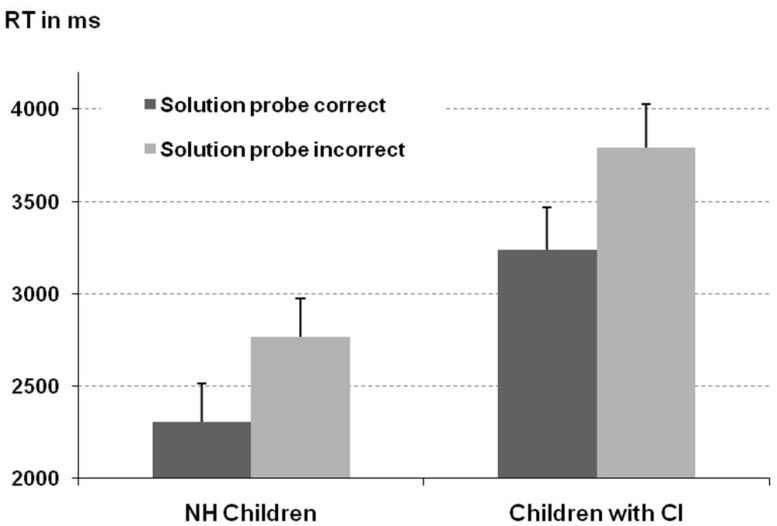
Response latencies separated for problem type (presented with either correct or incorrect solution probe) and participant group. Error bars represent one standard error of the mean (SEM).